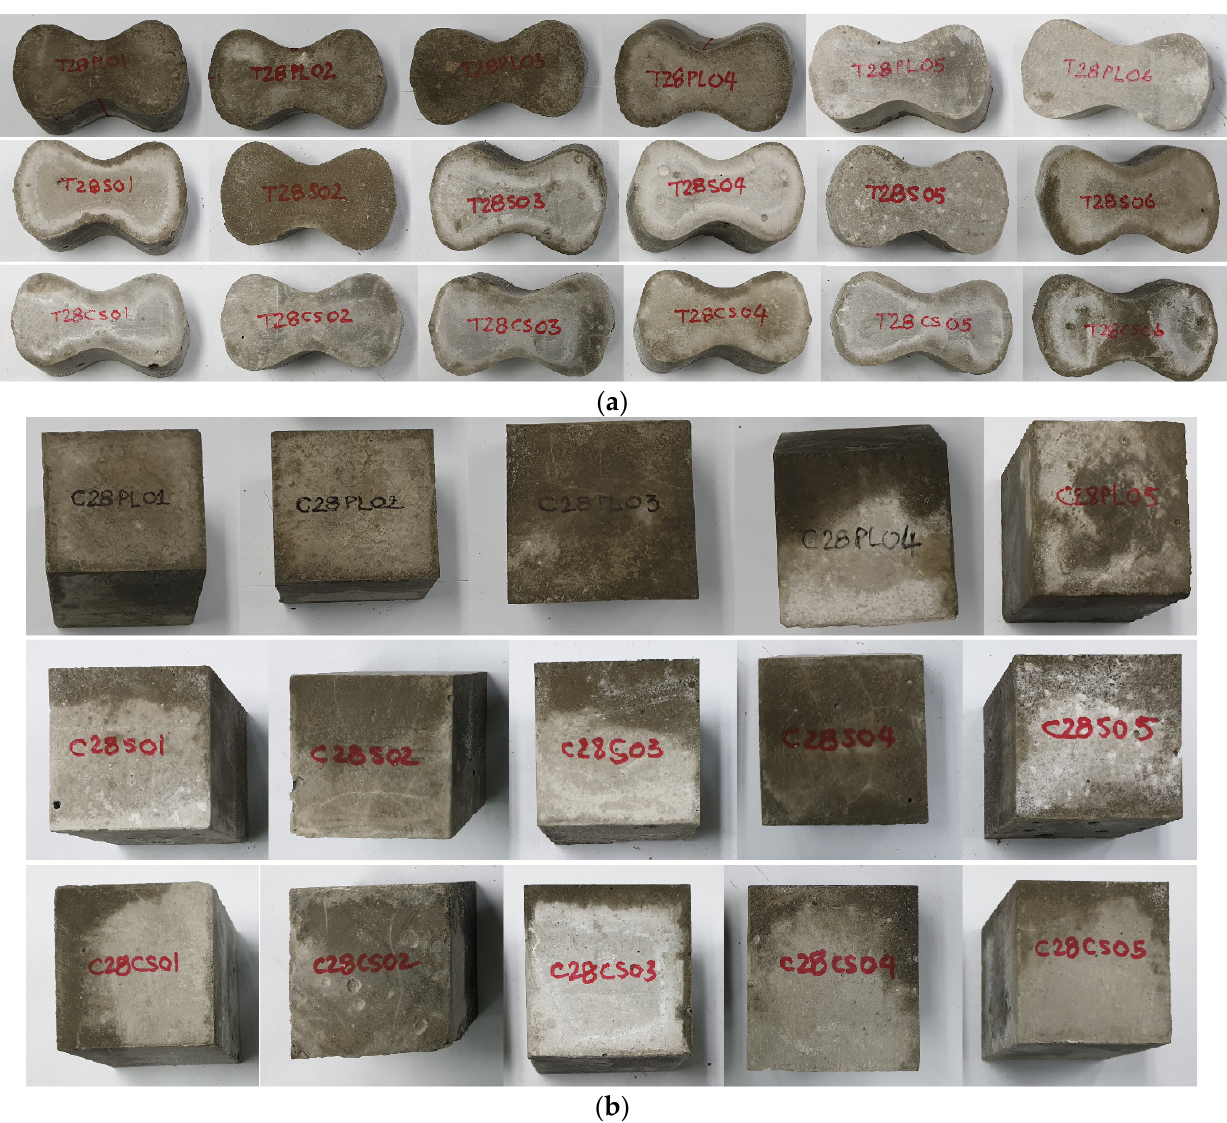
Figure 2. Samples for tensile and compressive strength tests: ( a ) dogbone samples for tensile strength test; ( b ) cubic samples for compressive strength test (T: tension; C: compression; 28: curing time (days); PL: plain paste; S: TEOS/PVP NFs-blended cement paste; CS: CNT-TEOS/PVP NFs-blended cement paste).